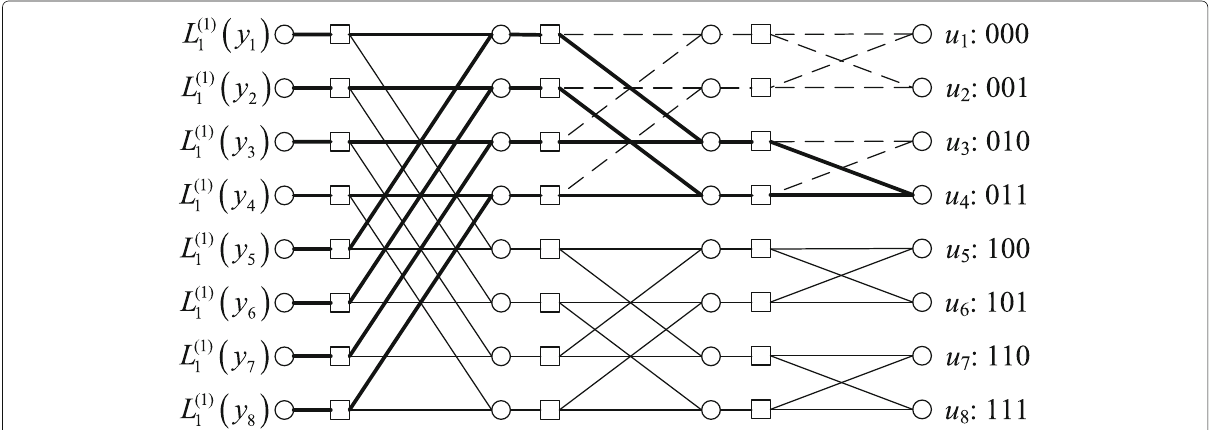
Fig. 1 Decoding graph of polar codes, N = 8. The recursive processes of the SC decoding for polar codes with the length N = 8. The thick solid lines show the decoding tree for the 4th